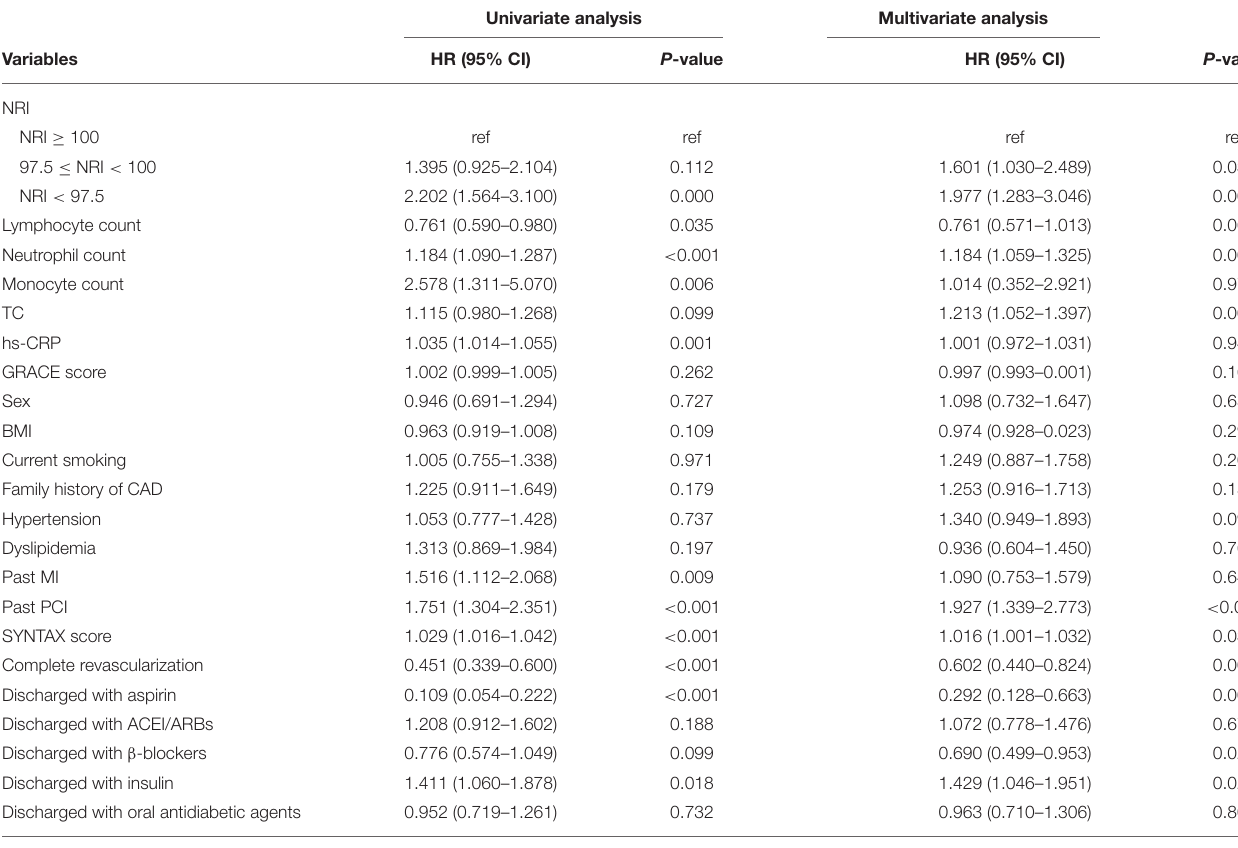
TABLE 5 | Relationship between MACE and NRI as a categorical variable in the diabetes subgroup.